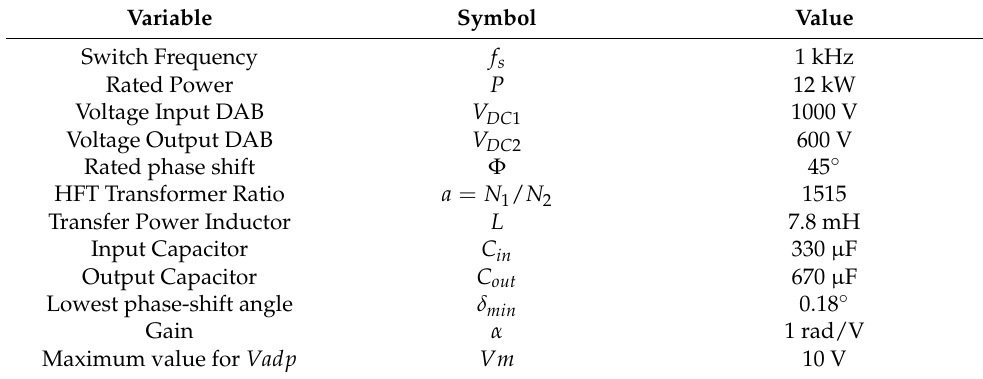
Table 2. DAB converter